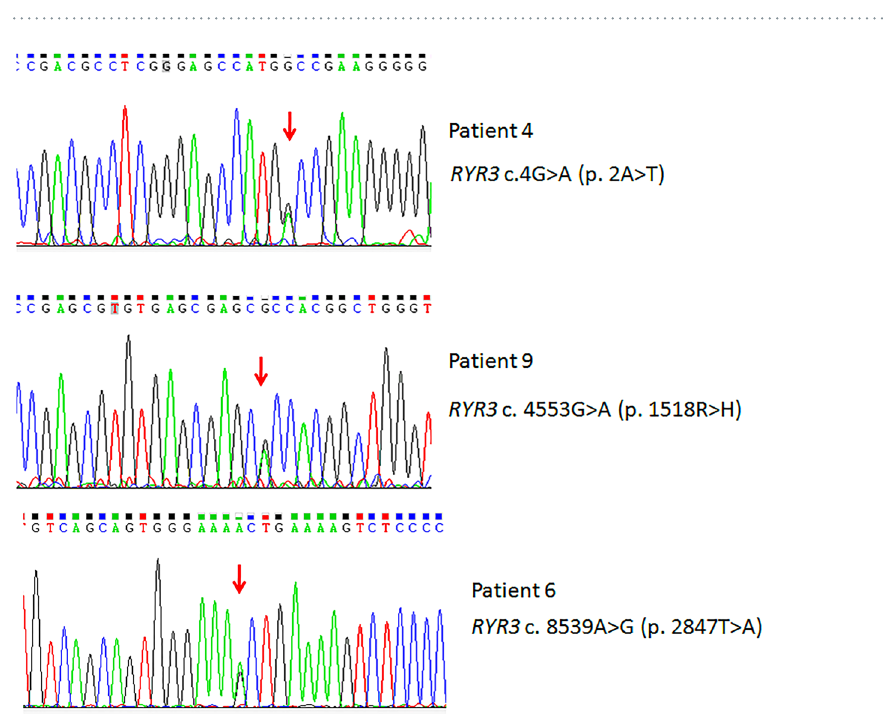
Figure 2. Heterozygotes RYR3 mutations are identified in three FtMs (Patient 4, Patient 6, Patient 9). All mutations were verified by Sanger sequencing. Red arrows indicate the positions of point